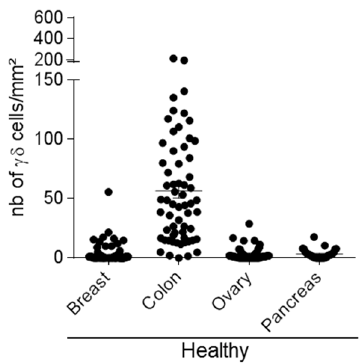
Figure 2. Heterogeneity of γδ T-cell density in normal tissues. Scatter plot showing γδ T-cell density assessed by IHC in tissue microarrays (TMAs) with normal breast ( n = 141), colon ( n = 62), ovary ( n = 49), and pancreas ( n = 31) samples. Data are presented as the mean ± SEM.